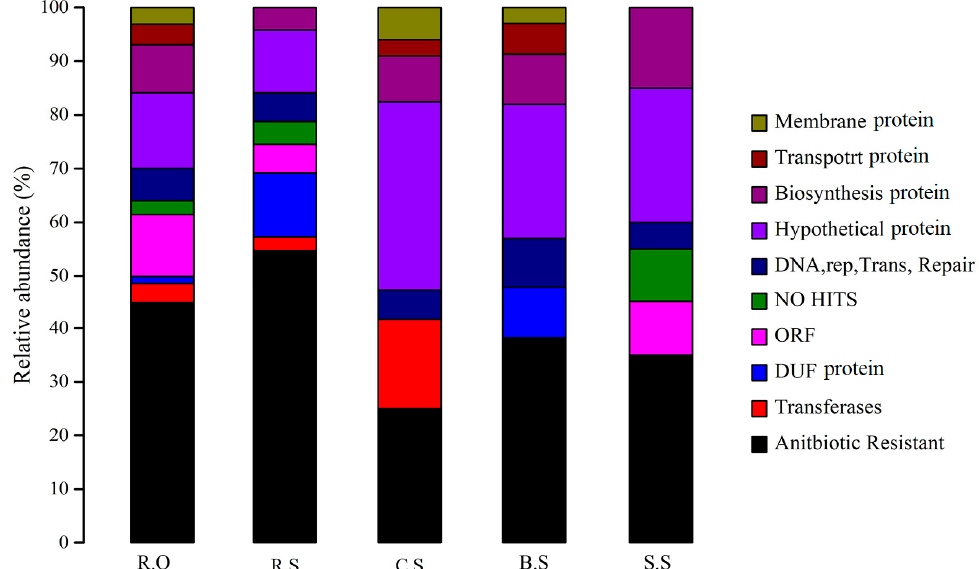
Figure 2. The relative abundance of different GCs transcribed into various proteins with various functions are represented by different colors from the bottom to the top of the bars. The distances covered by the various colors represent the relative abundance in that specific site. R.O—agriculture runoff site, R.S—rice field site, C.S—citrus field site, B.S-banana site, S.S—sugarcane site. A bar with